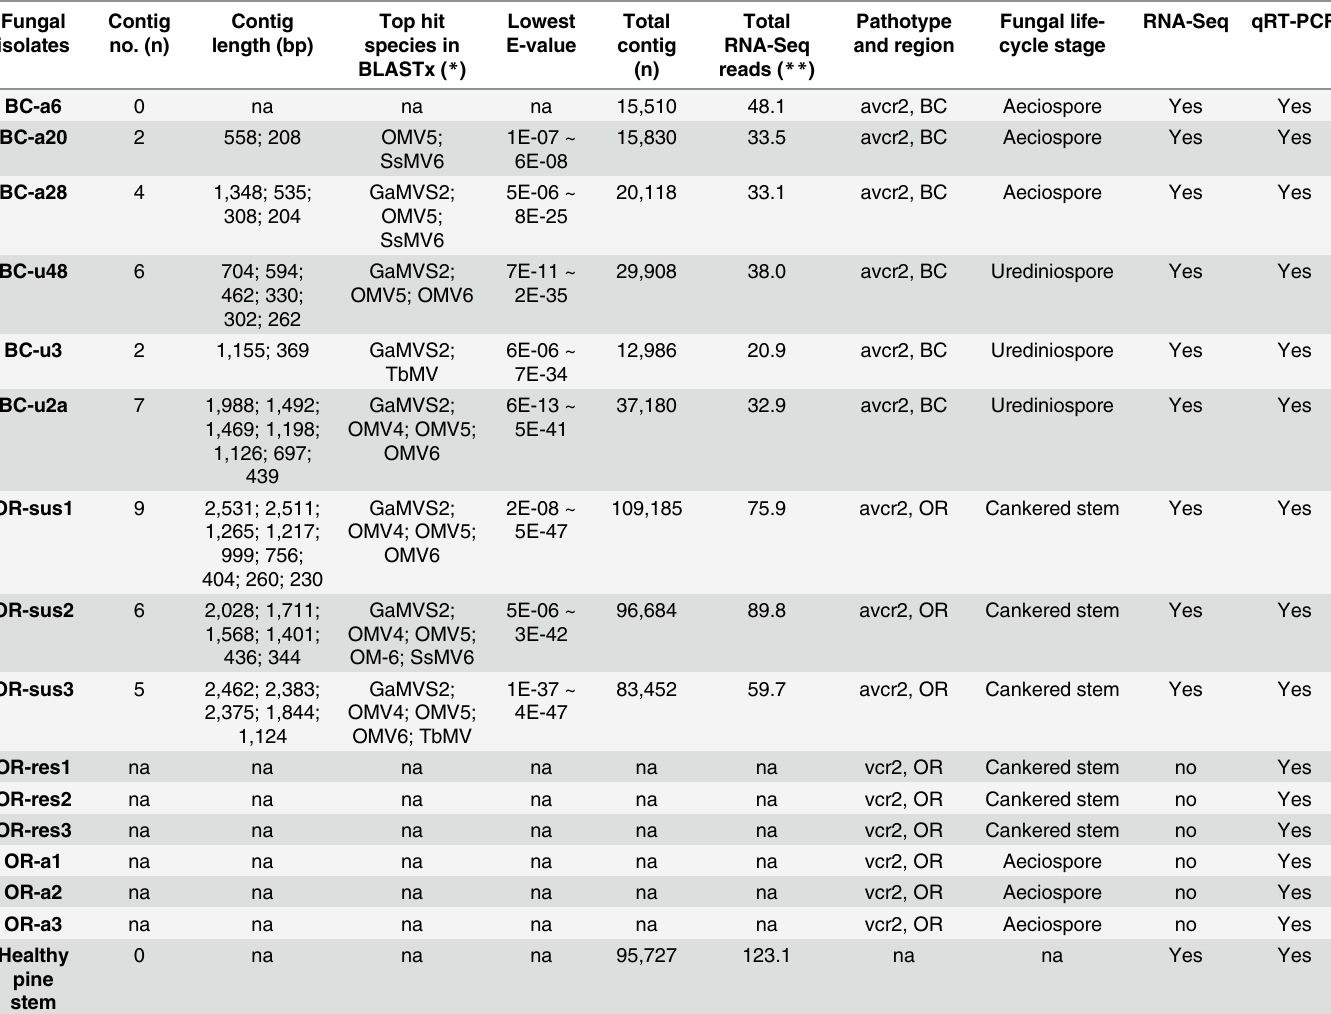
Table 1. Cronartium ribicola isolates and mitoviral contigs detected in their transcriptomes de-novo assembled in RNA-seq analysis. Fungal Contig isolates no.